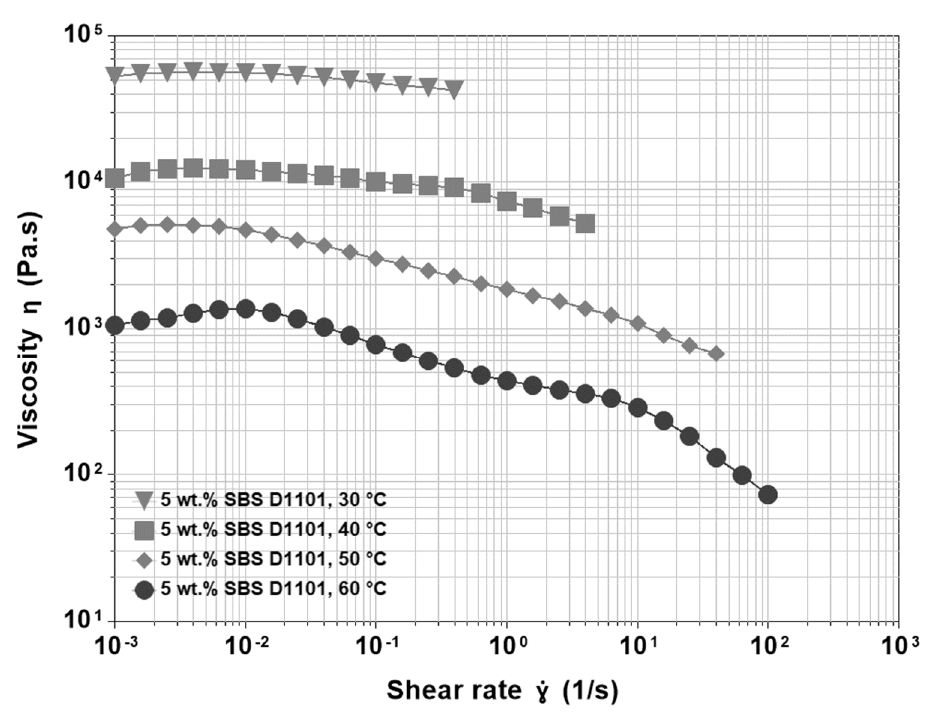
Figure 4. Viscosity functions at different temperatures for 200/300 Pen grade modified by 5 wt.% SBS D1101. SBS